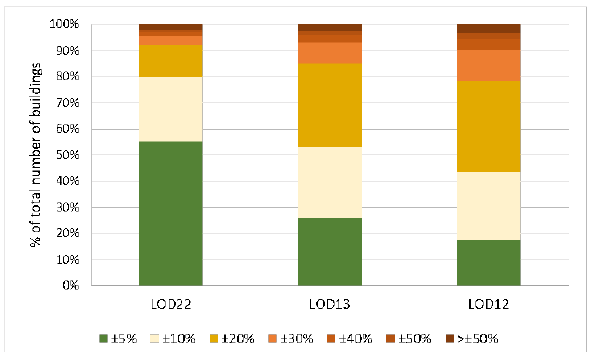
Figure 6. Buildings (in %) classified according to the respective interval of volume difference from the